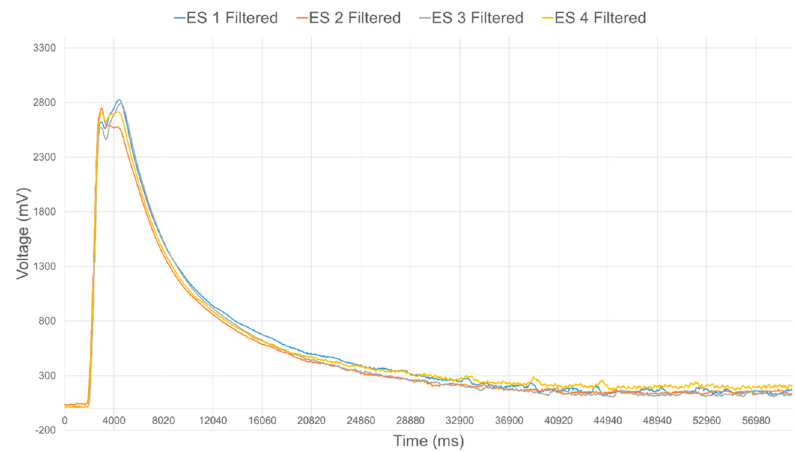
Figure 10. Filtered response of four individual IR range sensors over the full range of operation.